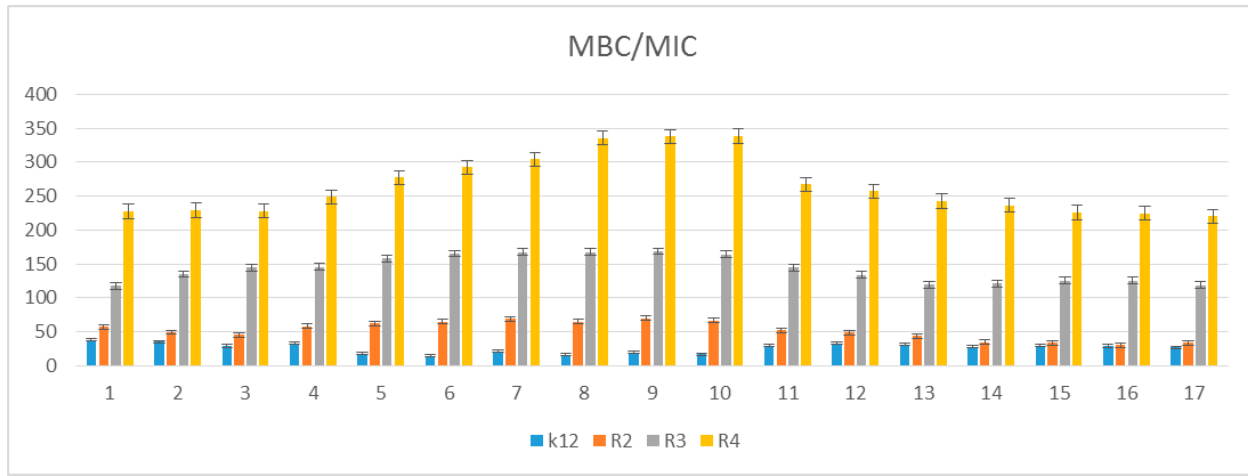
Figure 6. MBC/MIC of the lactones in model bacterial strains. The x -axis compounds 1–17 were used sequentially. The y -axis shows the MBC/MIC value in µg/mL − 1 .